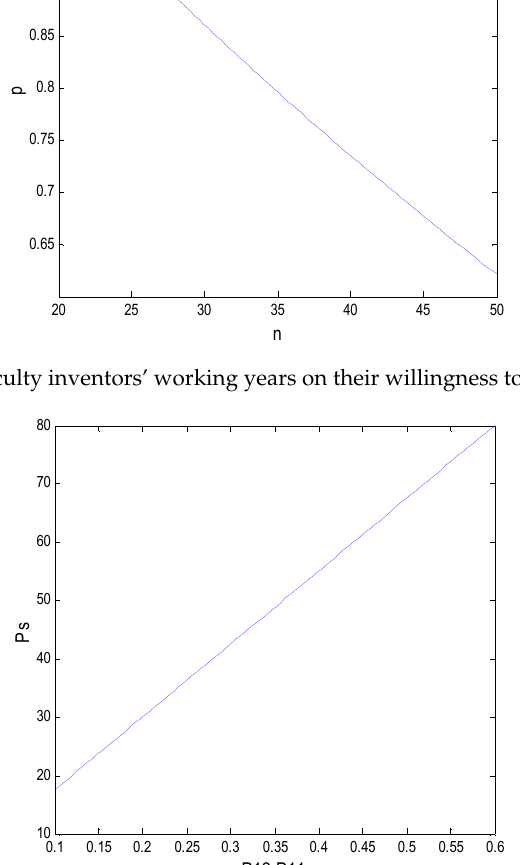
Figure 18. The e ff ect of the expected return di ff erence on the technological transaction Figure 17. The effect of faculty inventors’ Figure 18. The effect of the expected working years on their willingness to return difference on the technological “comply with the rules”. transaction prices.